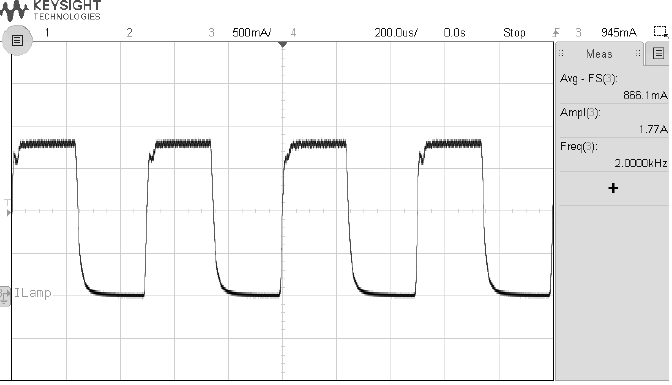
Figure 17. Experimental current of the lamp at 50% dimmed operation achieved by the phase-shifted PWM.